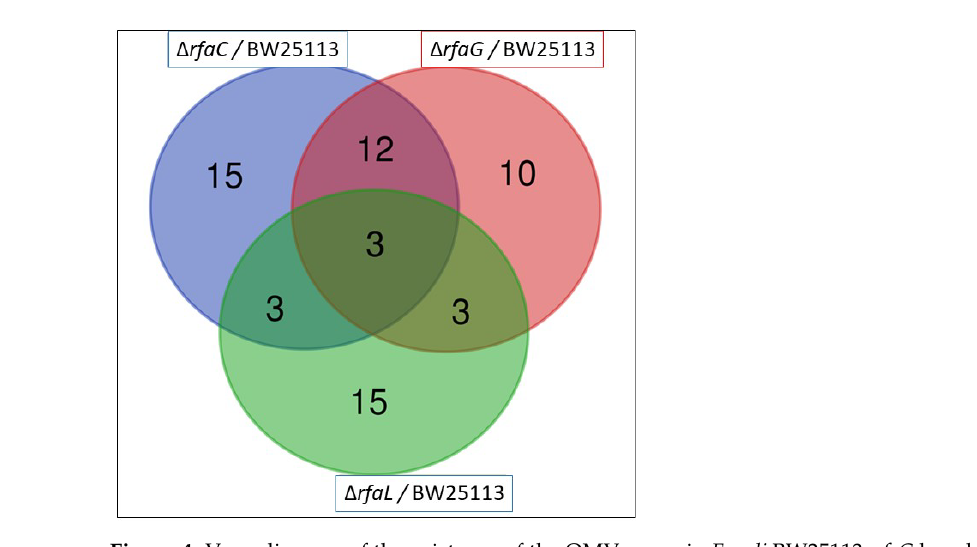
Figure 4. Venn diagram of the existence of the OMV genes in E. coli BW25113, rfaC knockout (ΔrfaC), rfaG knockout (Δ rfaG ), and rfaL knockout (Δ rfaC ) strains. Three strains encompassing rpsT , galF , and rpmB existed in the three E. coli mutants.